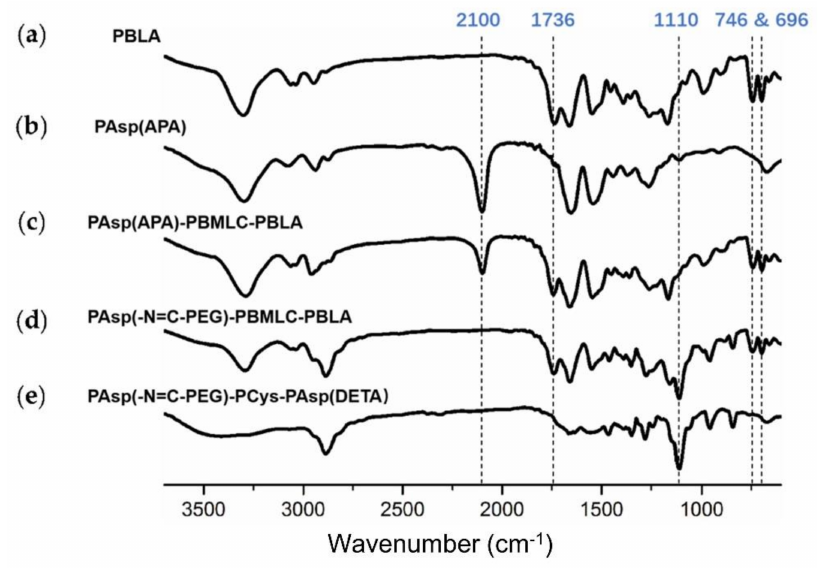
Figure 8. FTIR spectra of ( a ) PBLA, ( b ) PAsp(APA), ( c ) PAsp(APA)-PBMLC-PBLA, ( d ) Asp(-N=C- PEG)-PBMLC-PBLA and ( e )